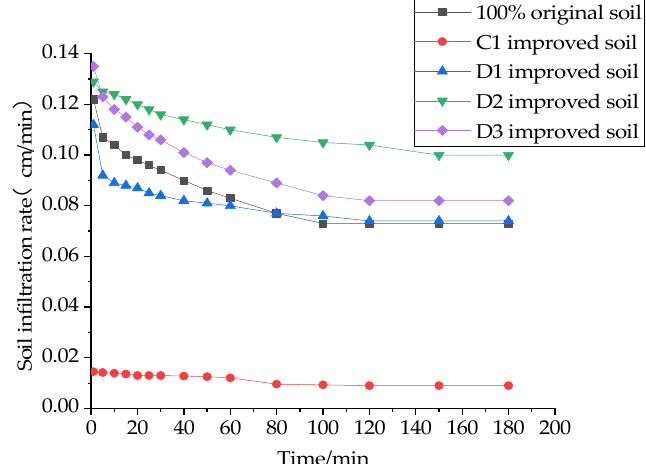
Figure 8. Effect of structural ameliorants on the soil infiltration rate.